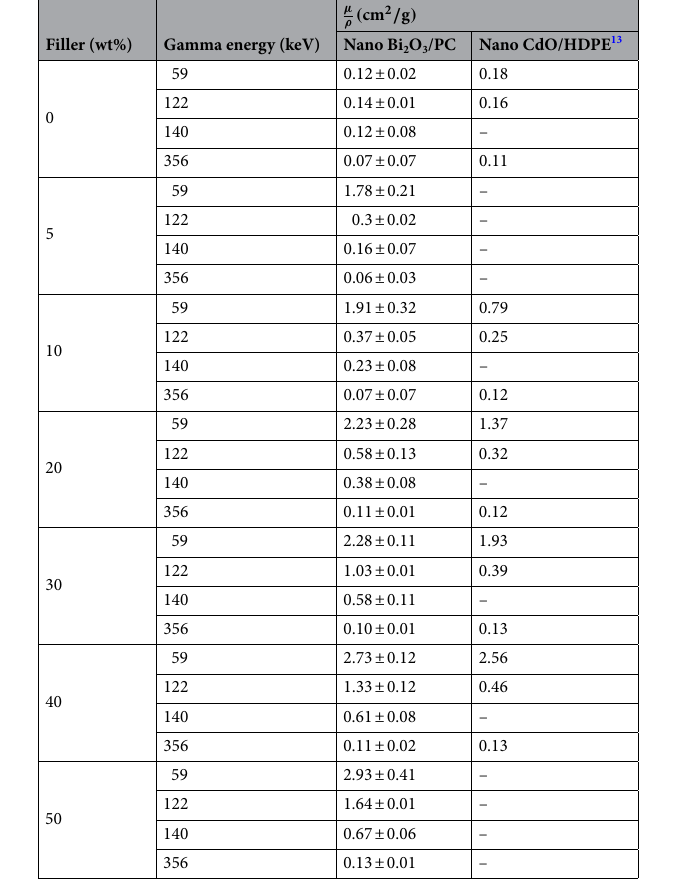
Table 6. Mass attenuation coefficient results for each weight fraction and different energy